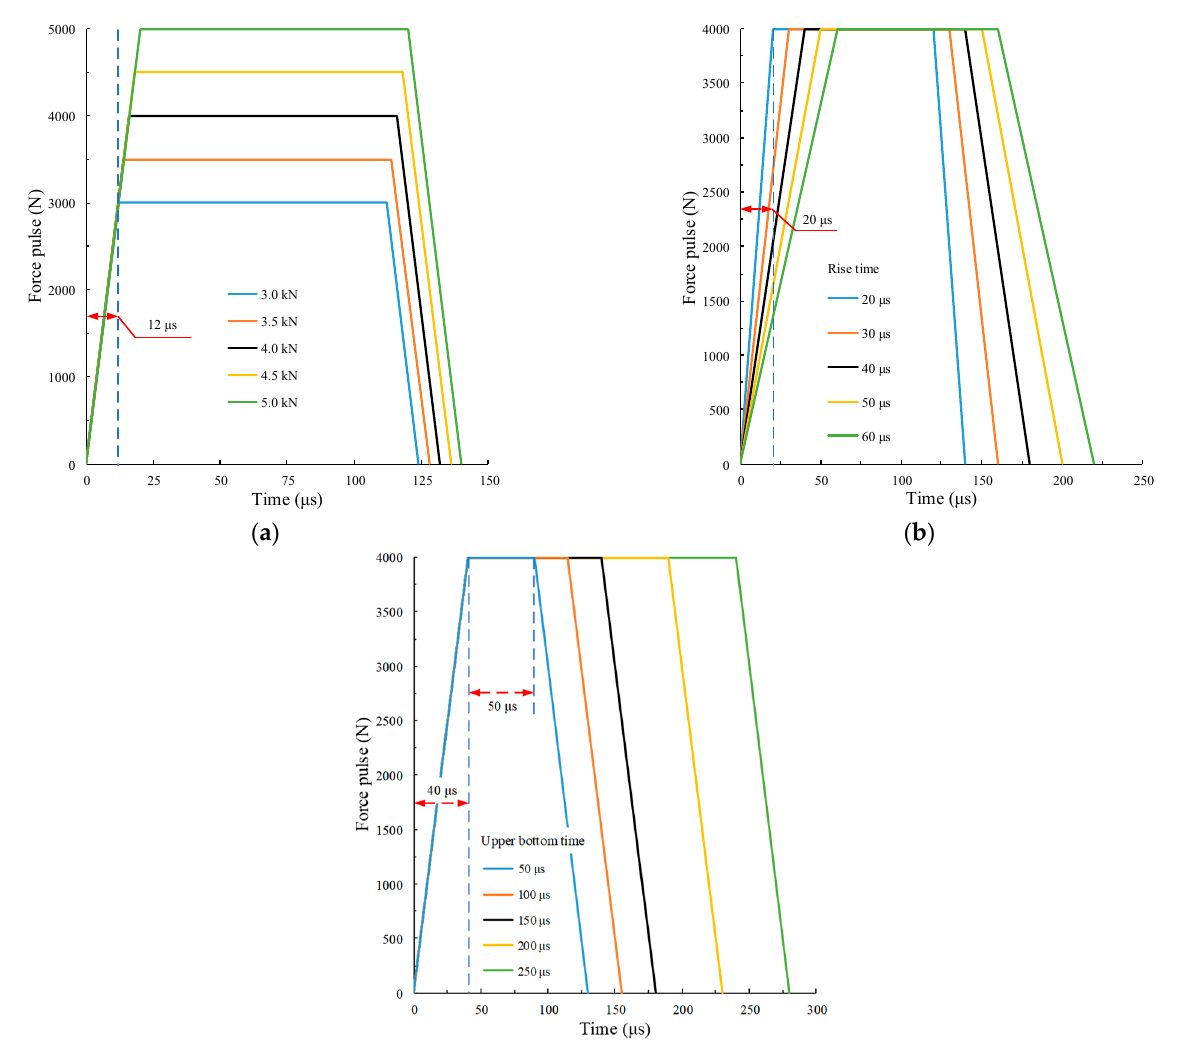
Figure 9. Velocity pulse waveform. ( a ) Different amplitudes; ( b ) different rise times; ( c ) different upper bottom times.